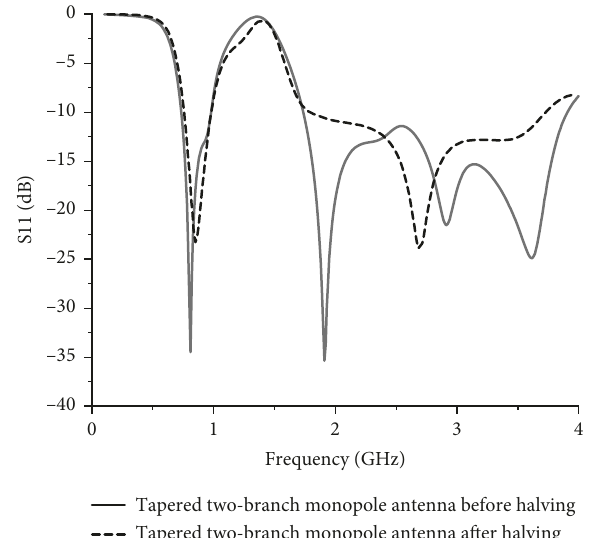
Figure 5: Comparison of a tapered two-branch monopole antenna before and after halving.